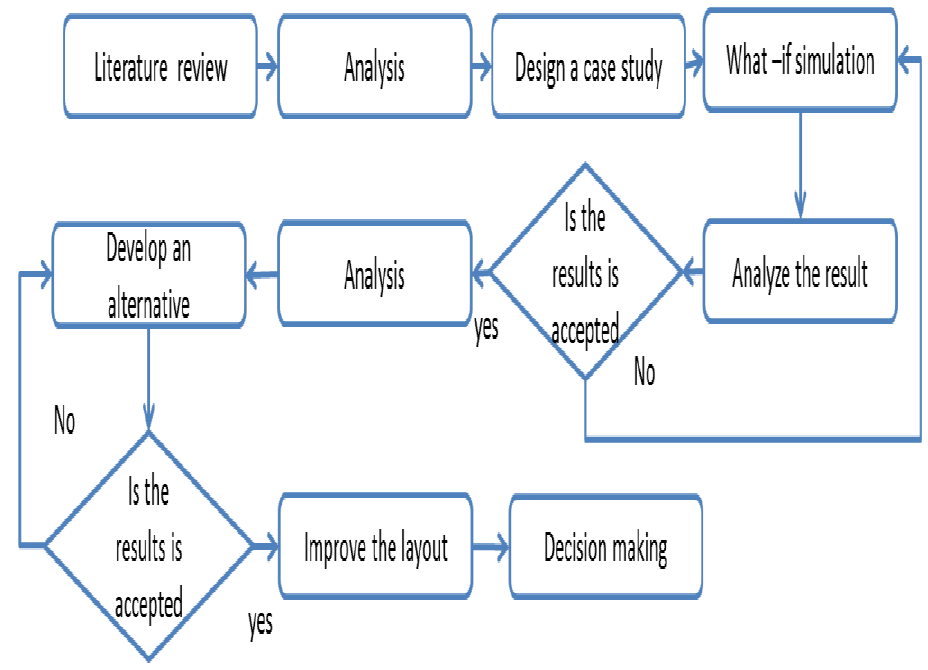
Figure 1: Research methodology flow